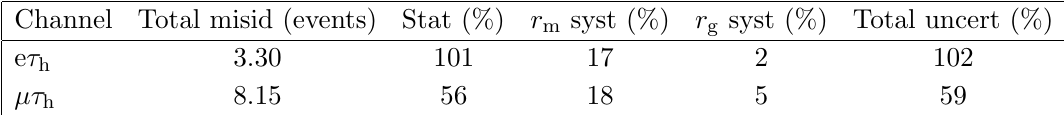
Table 5 . Estimation of the misidenti(cid:12)ed (cid:28) h contribution in the signal region of the ‘(cid:28) h channels. The total systematic uncertainty is the quadratic sum of the individual components. All uncertainties are relative. The r m ( r g ) is shorthand for misidenti(cid:12)ed (genuine) (cid:28) h candidate rate. the backgrounds for both the e (cid:28) h and (cid:22)(cid:28) h channels, the total systematic uncertainties